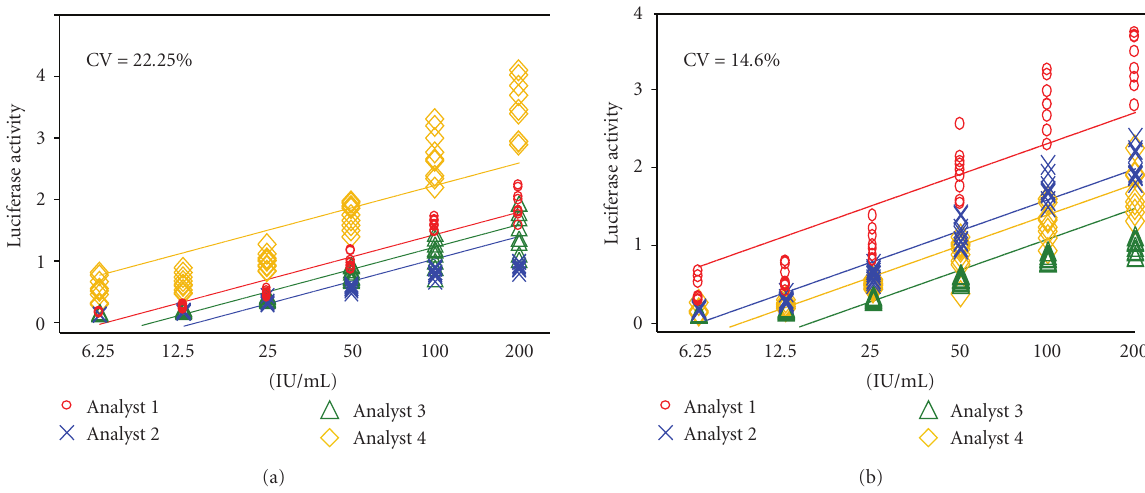
Figure 4: Determination of variability in experiments conducted by 4 di ff erent analysts. Two samples were used (both final products of IFN- β 1a). The analysts who had no prior experiences of conducting the assay were instructed to conduct the experiments by following the protocol. Each sample was run in triplicate and tested on 3 di ff erent plates. The graphs represent the linear range of the tested doses as determined by comparison to the international reference standard.